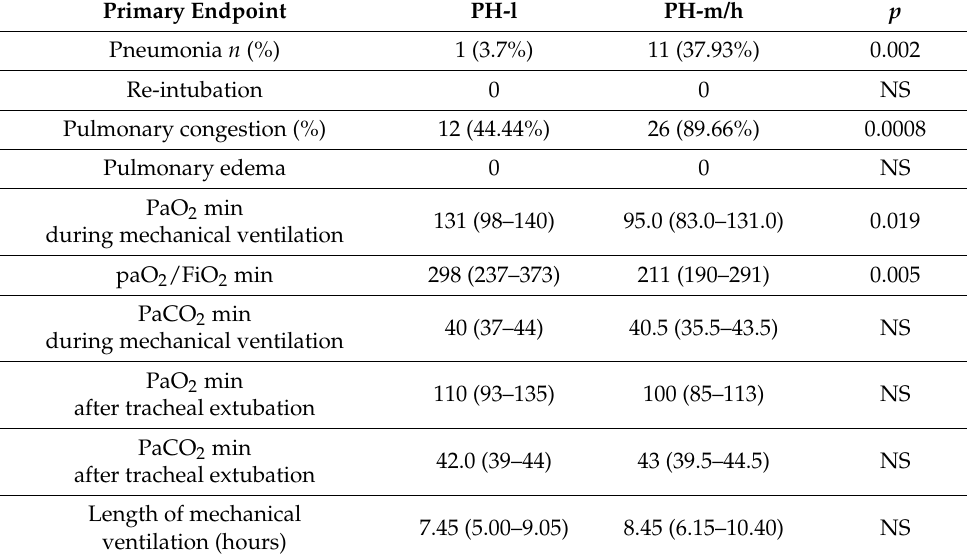
Table 6. Primary endpoints in PH-m/h and PH-l groups.